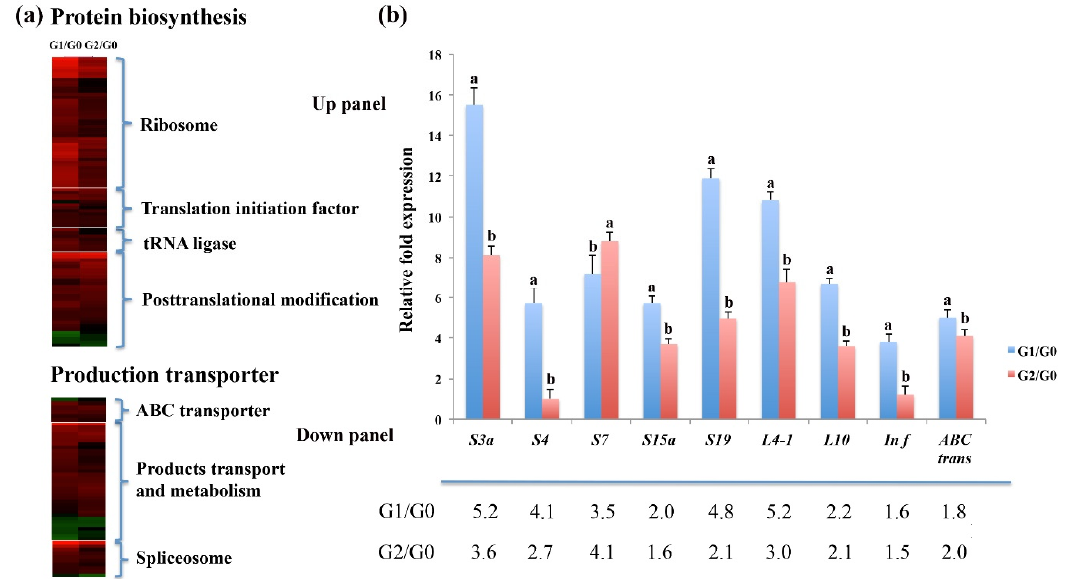
Figure 4. Protein synthesis and transporter functions in C. spinifex roots enhance drought tolerance. ( a ) Heat map of protein synthesis and transporter proteins. ( b ) Upper panel: Expression of nine candidate genes encoding DAPs (seven ribosomal proteins, a translational initiation factor and an ABC transporter) analyzed by real ‐ time PCR. Data are means ± standard deviations ( n = 3). Different superscript letters indicate statistically significant ( p < 0.05) differences between G1 vs. G0 or G2 vs. G0 based on the Student’s t ‐ test. Lower panel: The differential abundance of corresponding DAPs in C. spinifex roots in response to drought stress.